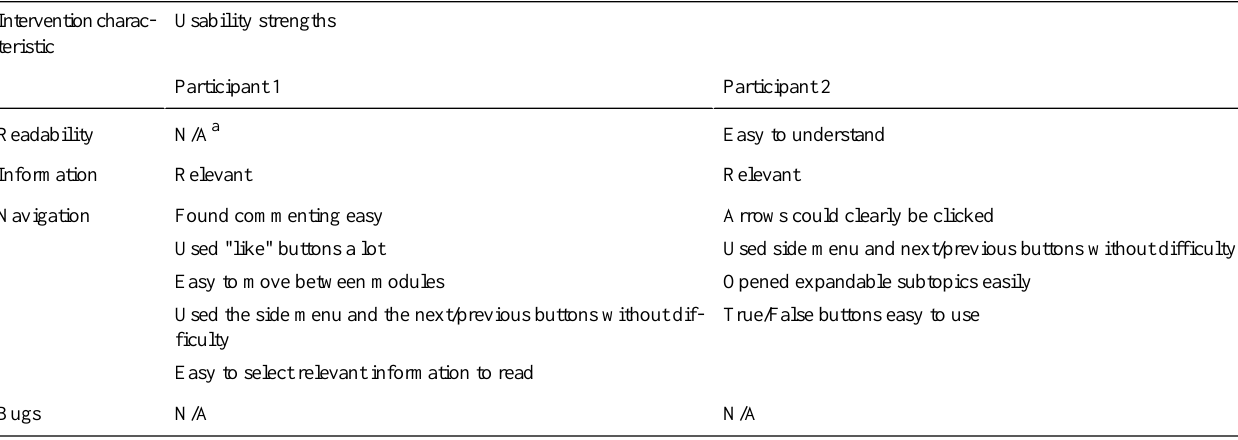
Table 2. Usability strengths identified in think-aloud